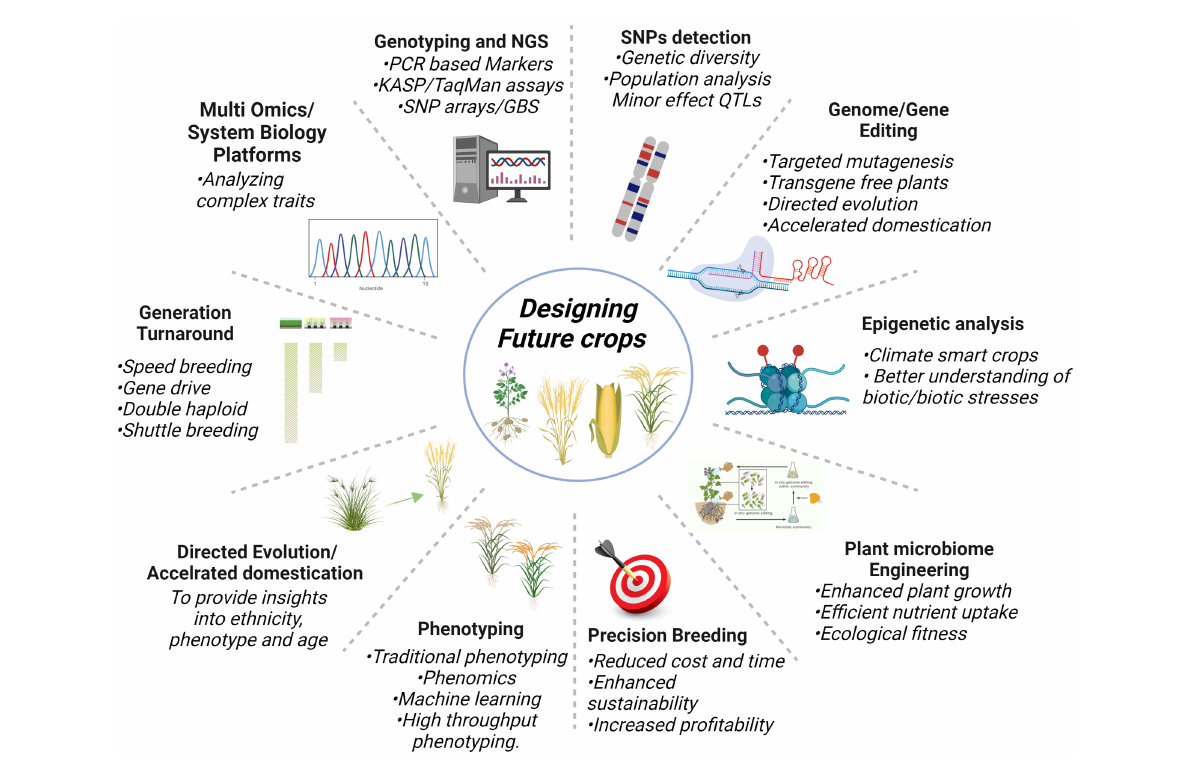
FIGURE5 Cutting edge new plant breeding innovative technologies having the potential to turnaround the problems of food